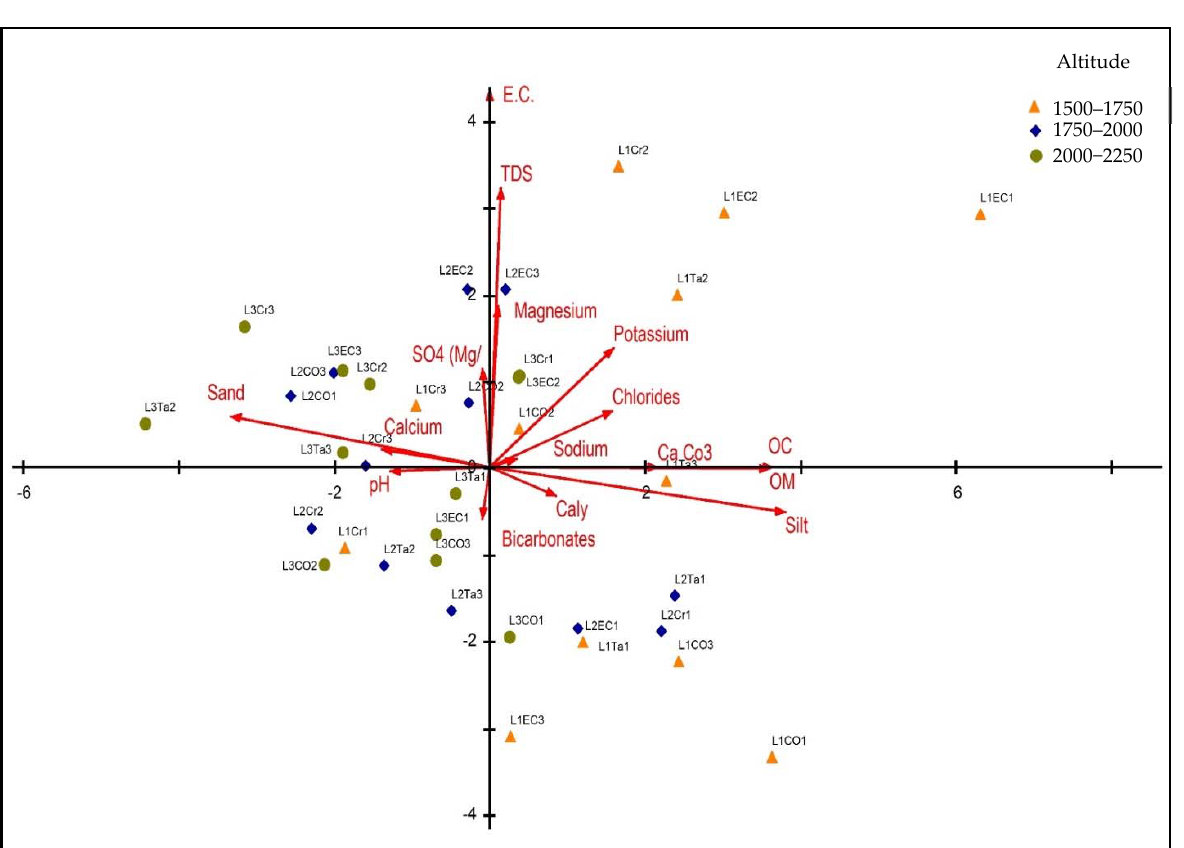
Table 2. ( a ) Mean ± SE of soil samples characteristics (pH, E.C, TDS, O.C, O.M, clay, sand, and silt contents) for the studied species at different altitudes. Abbreviations: L1 = altitude 1; L2 = altitude